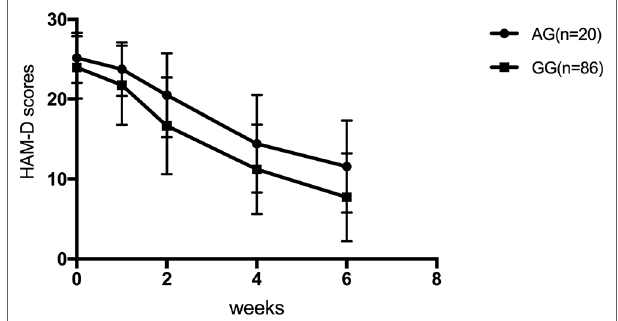
TABLE 9 | Rs2235015 and response to antidepressants.